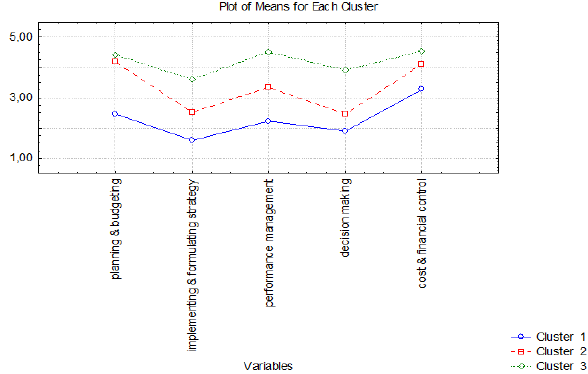
Fig. 3. The results of object (respondent) grouping with the k-means method as regards the use of management accounting information for indicated management tasks by managers in Poland.